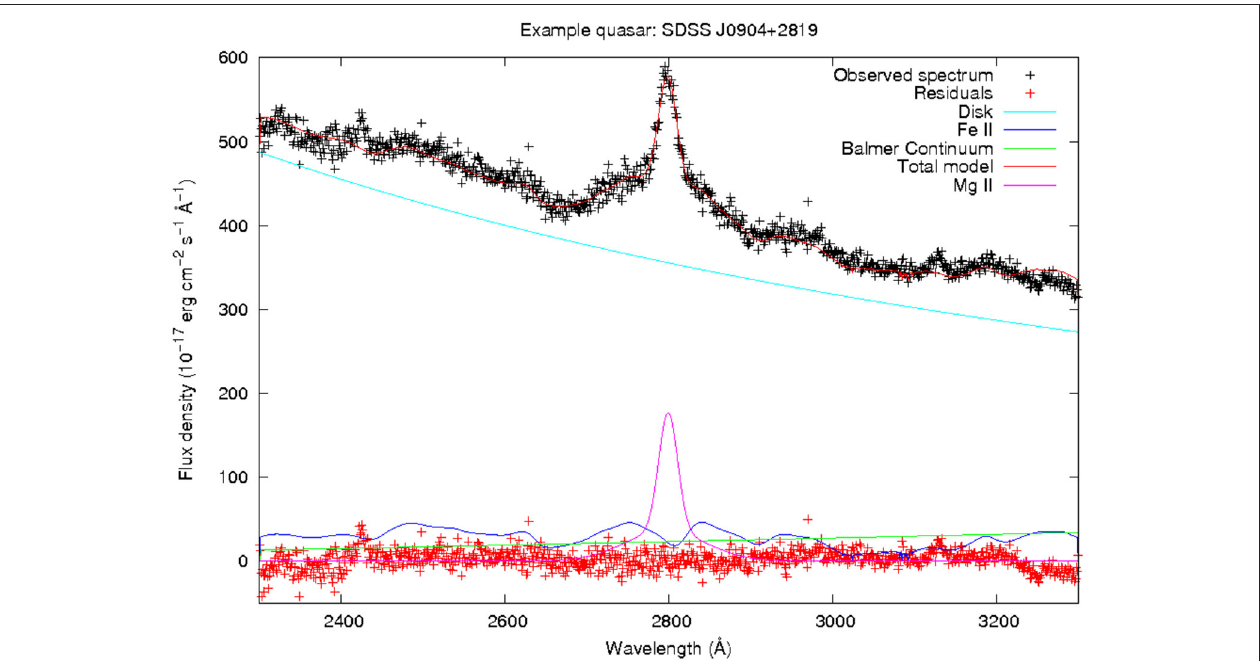
FIGURE 1 | Final fit to the spectrum of quasar SDSS J090429.62 + 281932.7 (black crosses) showing all four spectral components and the total model. Residuals are the difference between the total model and the observed